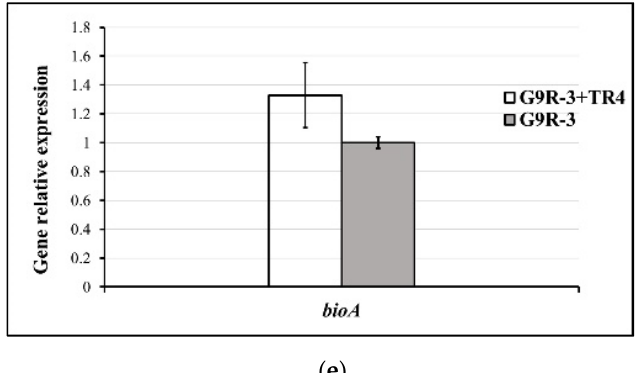
Figure 7. Biocontrol bioA gene expression profiles of five Bacillus strains: N67, YN1282-2, WBN06, HN04 and G9R-3. ( a – e ): each represent bioA gene’s expression levels of N67, YN1282-2, WBN06, HN04 and G9R-3. The asterisk represents a significant difference in gene expression between single and dual-cultures (Student’s t -test: p < 0.01 “**”, p < 0.001 “***”).